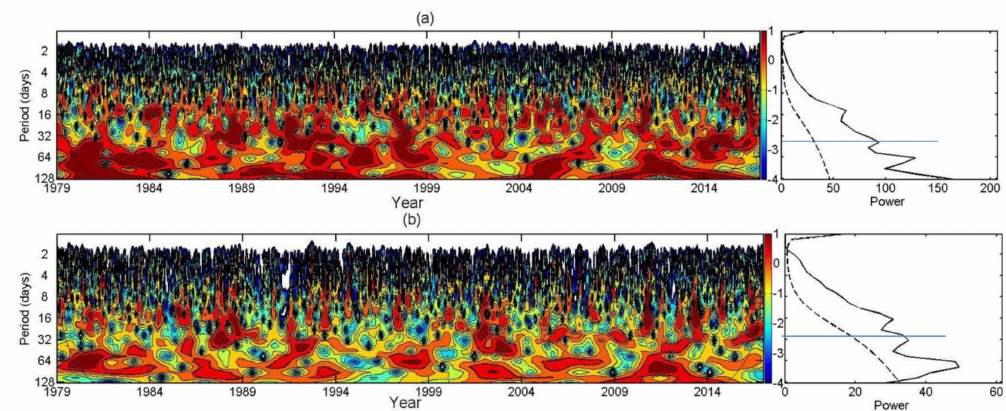
Figure 6. The wavelet power spectrum (left) and the global wavelet spectrum (right) for wintertime temperature ( a ) and specific humidity ( b ) di ff erences between 850 and 950 hPa at the location (75 ◦ N, 155 ◦ W) for the 1979–2016